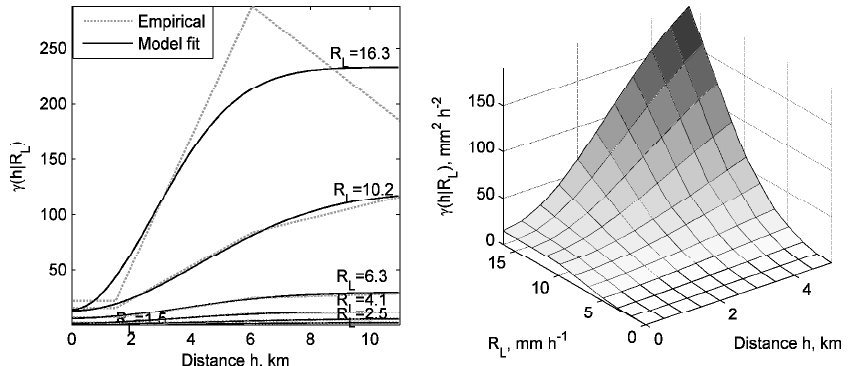
Fig. 6. Examples of empirical and model conditional semivariograms for different values of R L (left) and the resulting three-dimensional function γ (h | R L ) (right), 10min